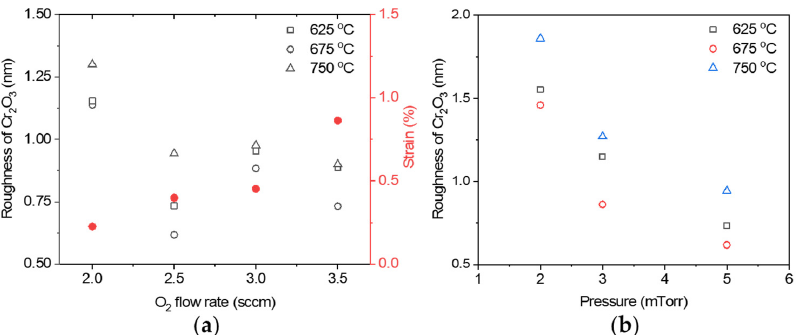
Figure 3. ( a ) Surface roughness of Cr 2 O 3 films with thickness of 20 nm deposited at different temperature and in-plane compressive strain in Cr 2 O 3 at 675 ◦ C as a function of oxygen flow rate. The open symbols show the surface roughness, and the filled circles show the in-plane strain in Cr 2 O 3 films. ( b ) Surface roughness of the films as a function of deposition pressure.